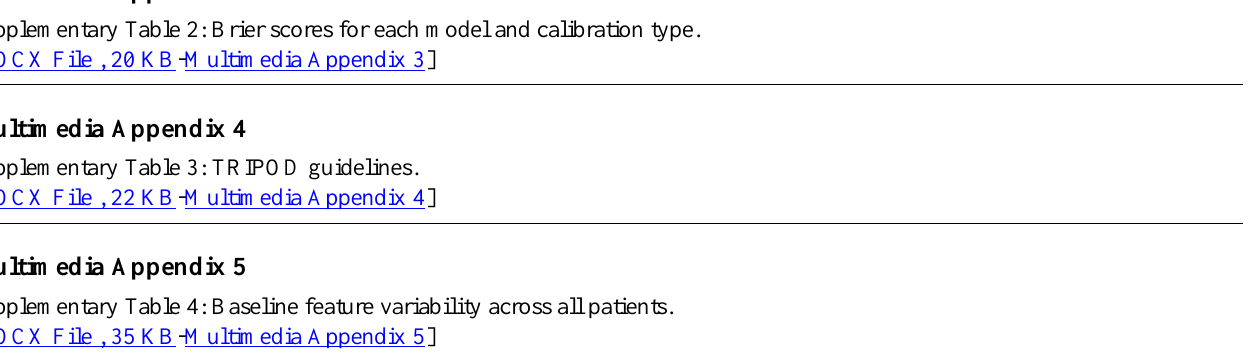
Supplementary Table 4: Baseline feature variability across all patients.